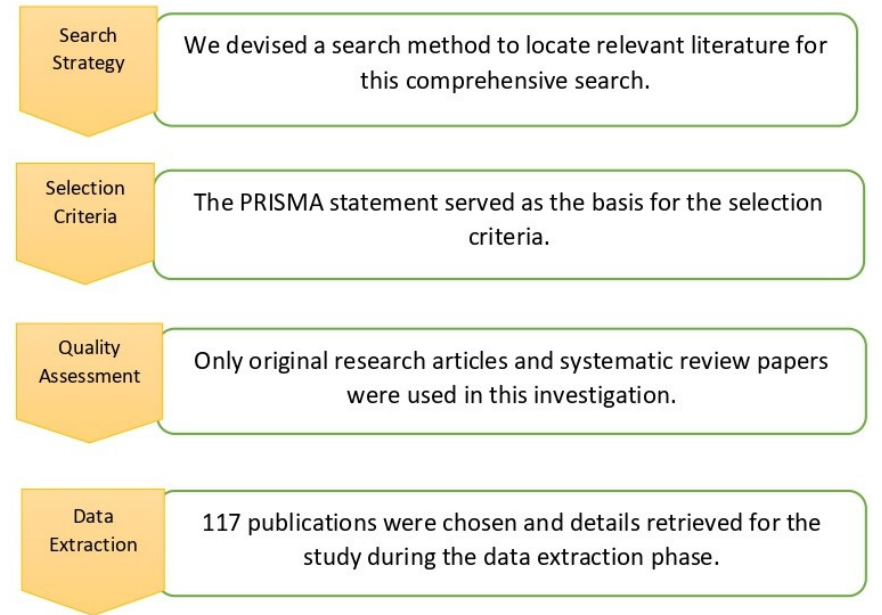
Figure 1. PRISMA framework method steps.